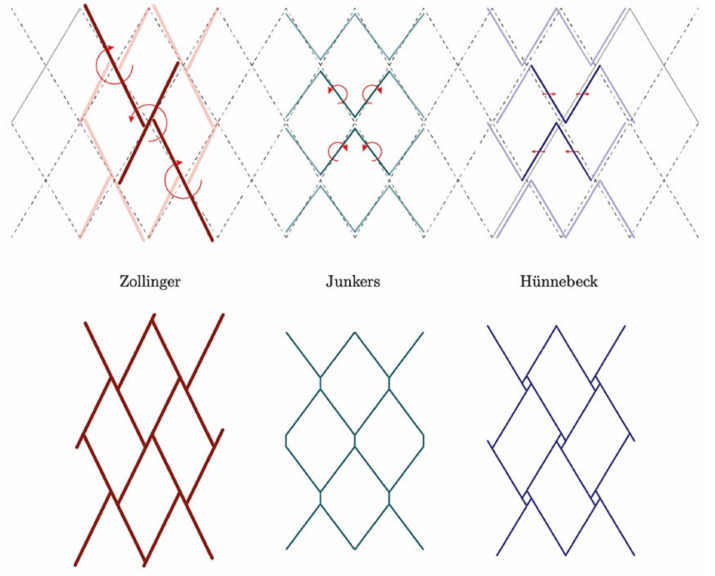
Figure 3. Diagrams showing three types of lamella vaults and the rotation/translation of the lamellae ( up ) with different types of nodes ( down )